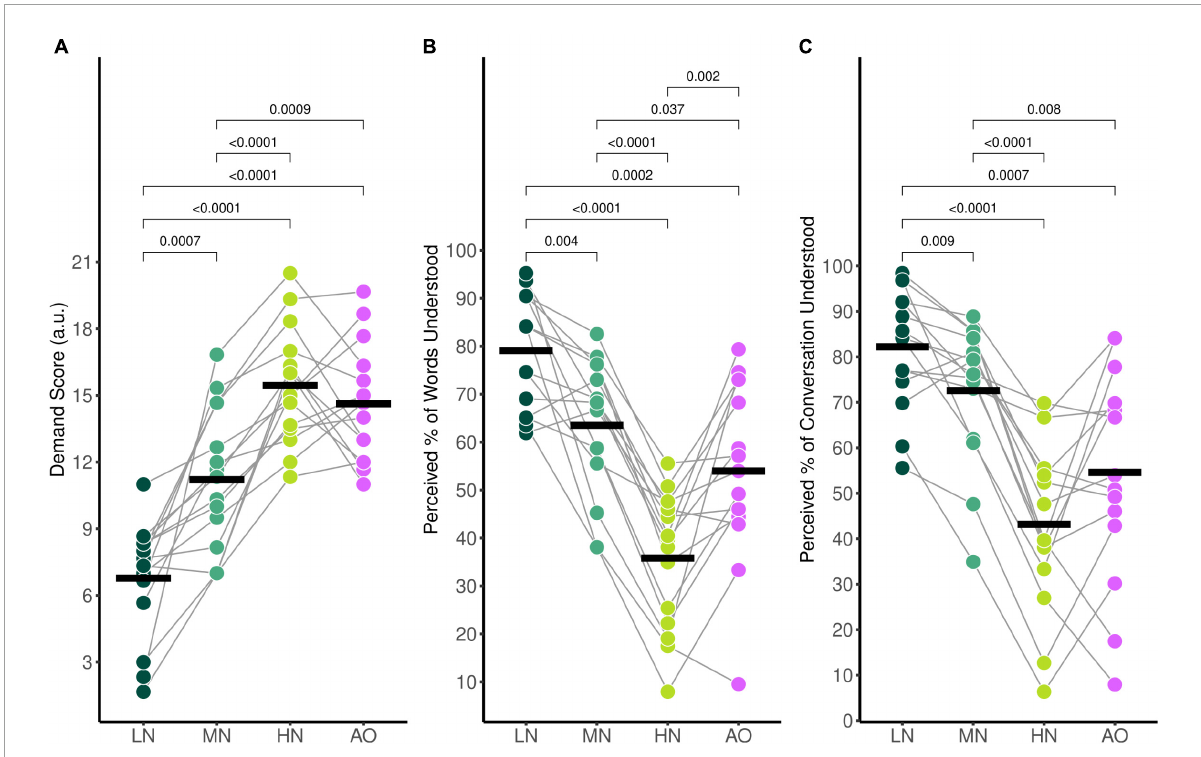
FIGURE2 Average self-reported behavioural ratings for (A) mental demand, (B) perceived percentage of words understood, and (C) perceived percentage of the conversation understood. Black horizontal bars indicate the mean score of each condition. Only significant comparisons are displayed.